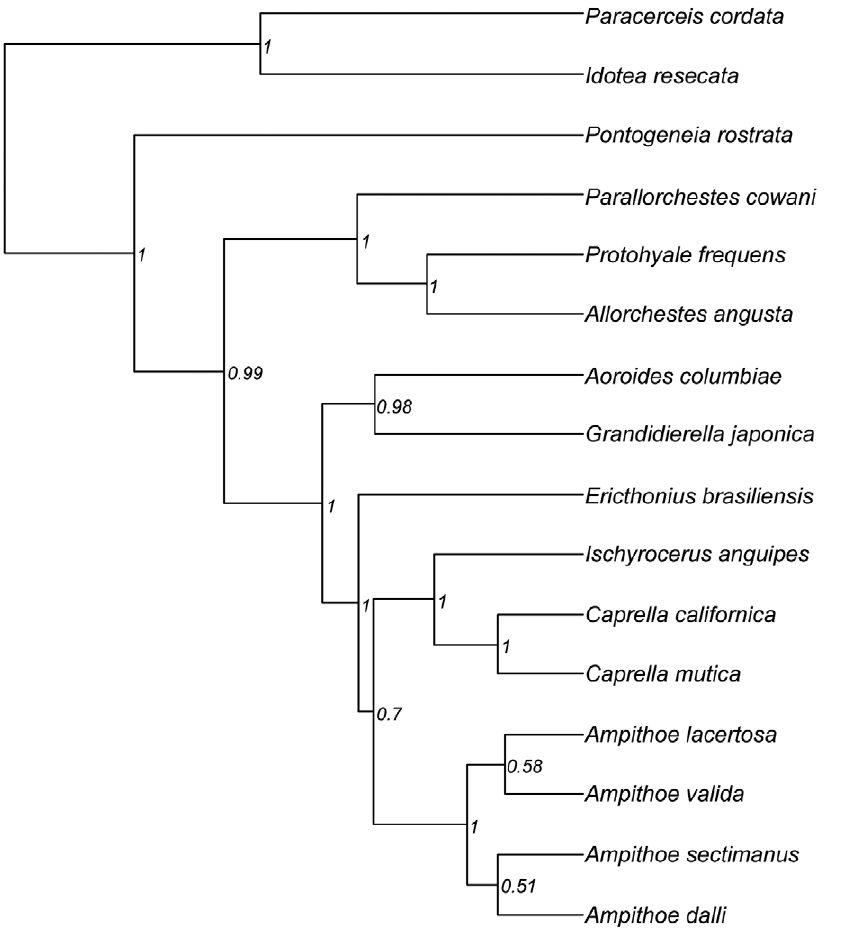
Figure 1. Maximum clade credibility ultrametric phylogeny for the 16 Bodega Bay species. Obtained from BEAST analyses using all genes (COI, 16S, 18S), branch lengths are in uncalibrated (relative) time units. Node labels are posterior probabilities. The isopods ( Paracerceis cordata and Idotea resecata ) are the outgroup.